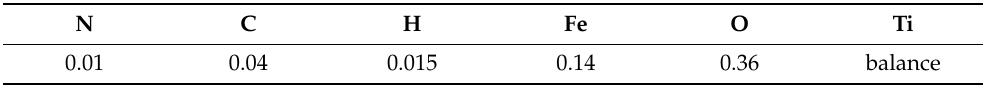
Table 1. Chemical composition of Grade 4